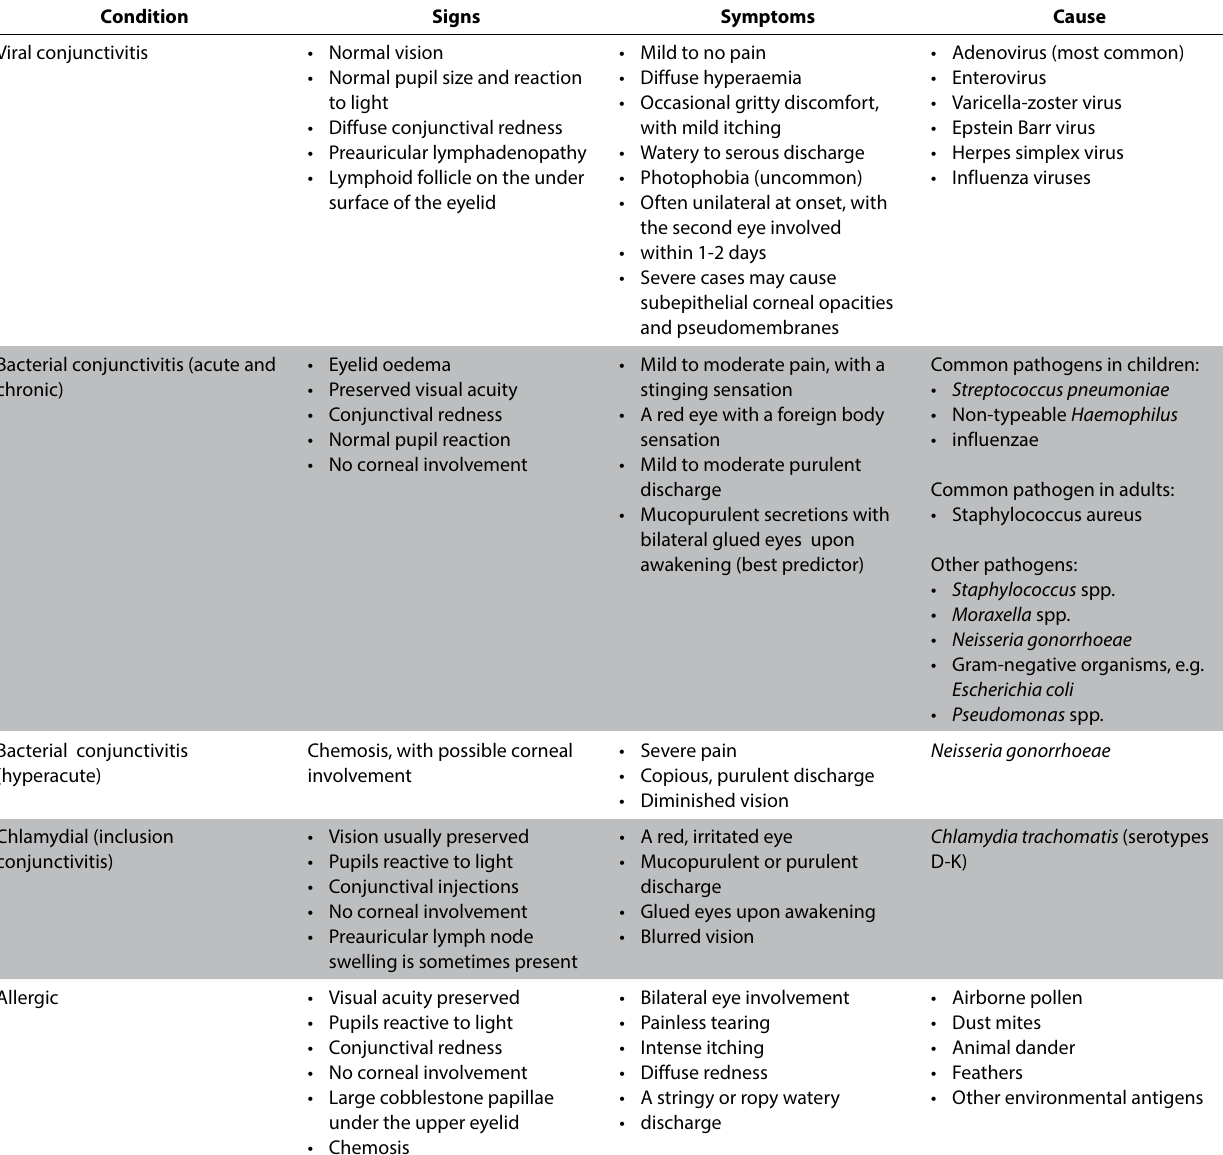
Table I: Differential diagnosis of a red eye due to conjunctivitis 2